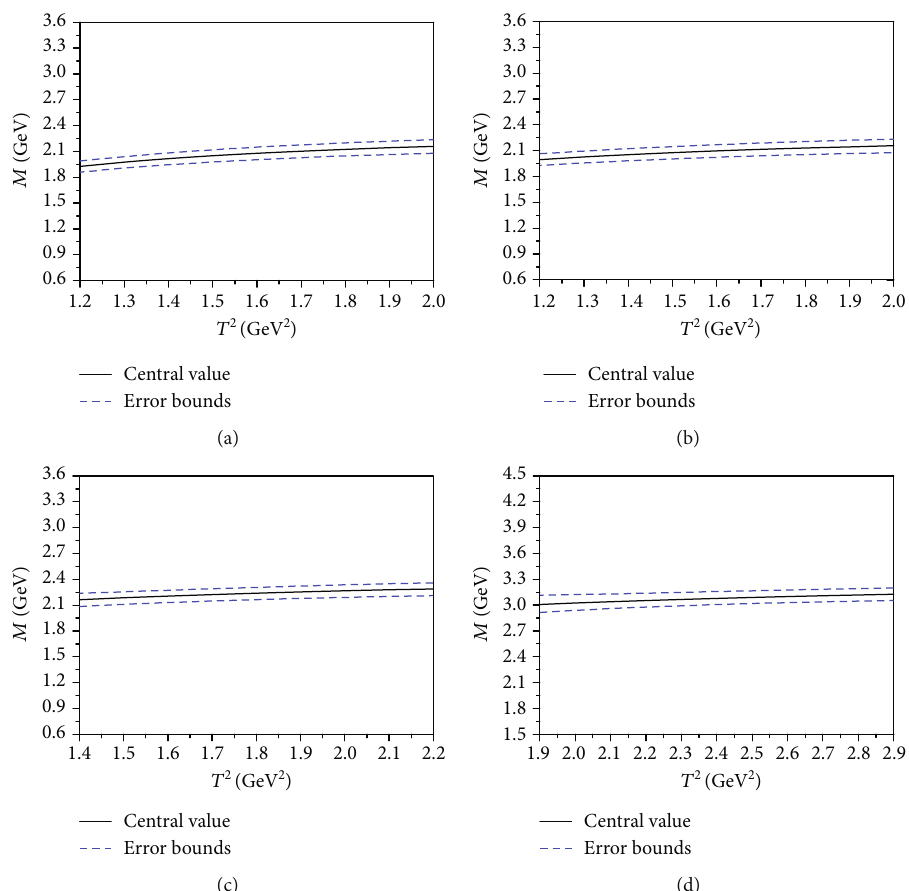
Figure 2: The masses with variations of the Borel parameters T 2 , where (a), (b), (c), and (d) denote the scalar, axialvector, tensor, and vector tetraquark states,